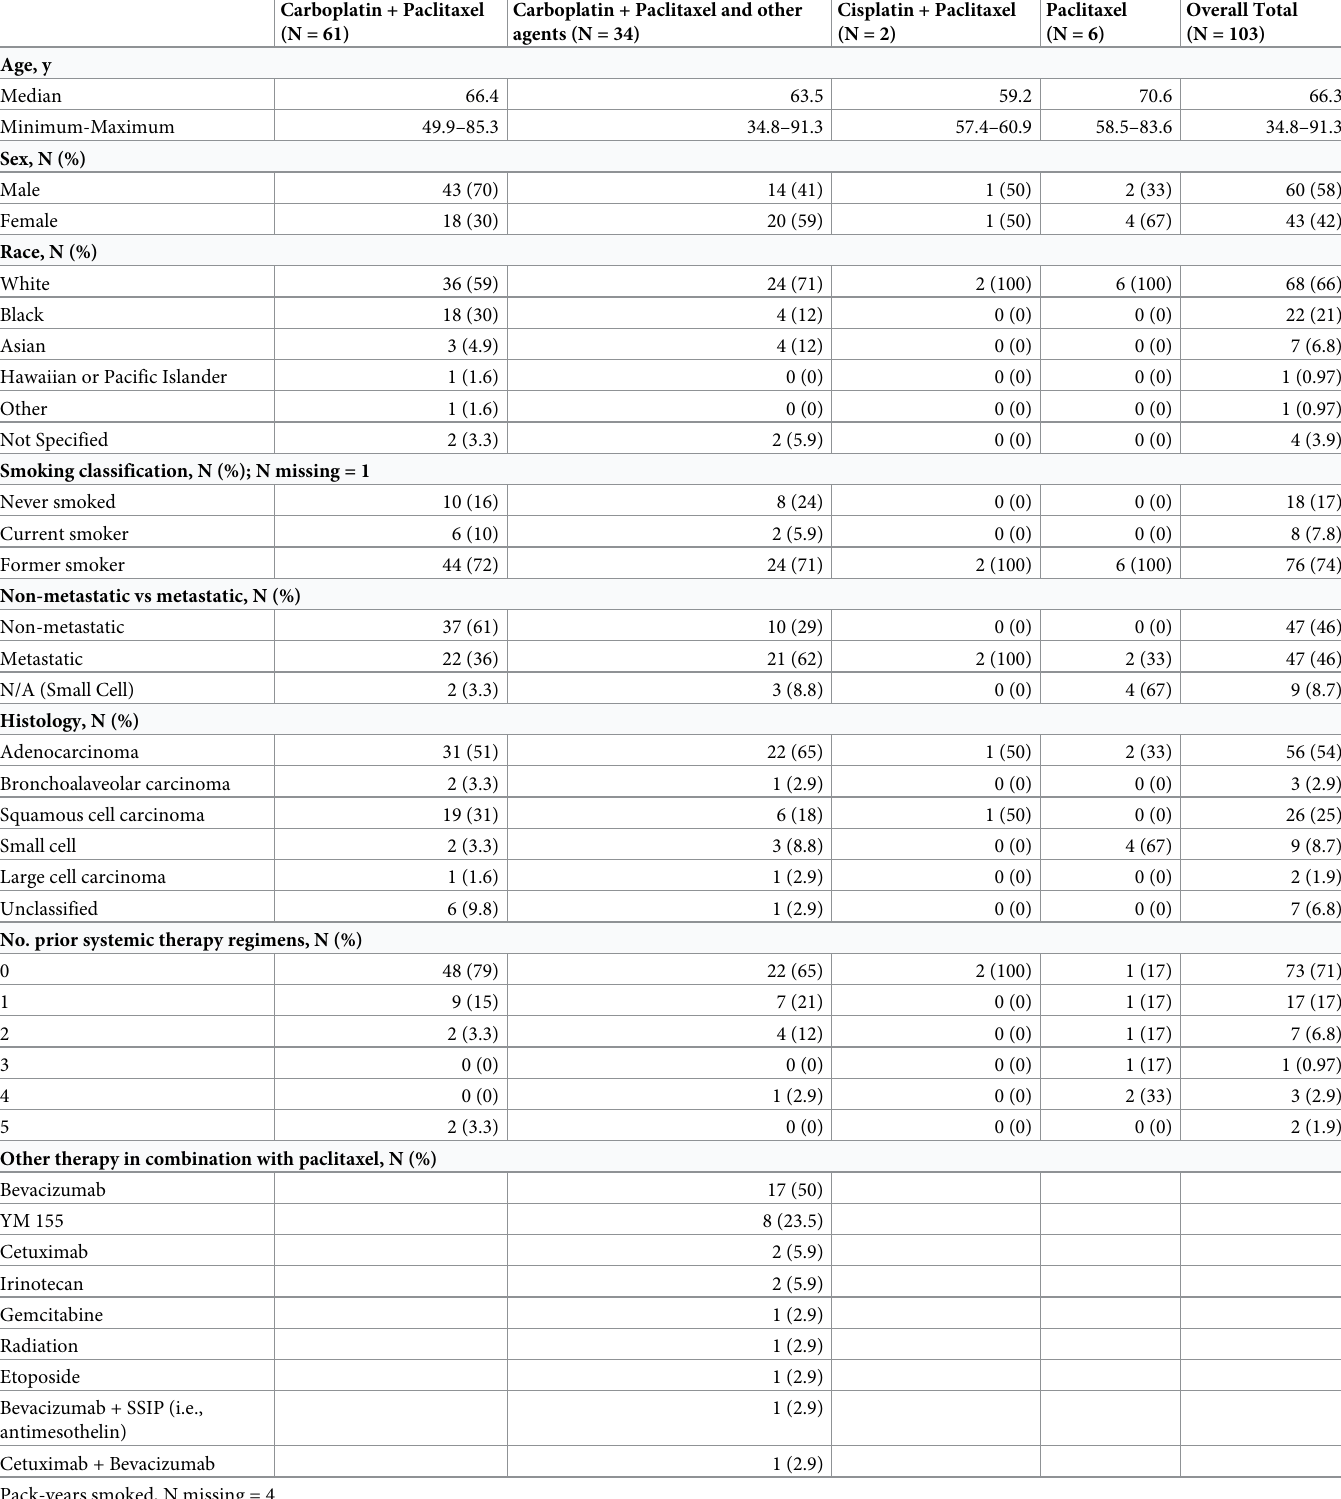
Table 1. Patient demographics, baseline disease characteristics, and treatment (safety analysis